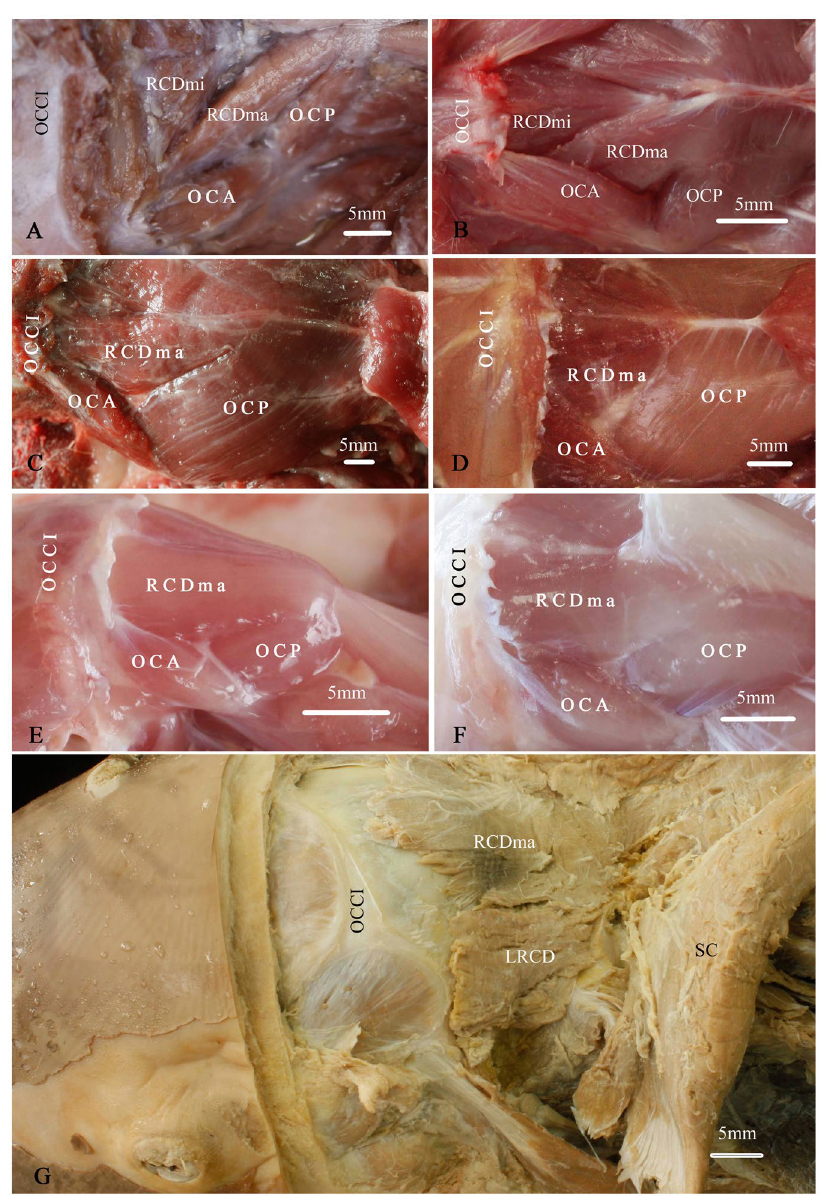
Figure 1. The post-occipital muscle group of five mammalian orders of mammals showed by the gross dissection (dorsal and lateral view). ( A ) Macacamulatta . ( B ) Oryctolaguscuniculus . ( C ) Canisfamiliaris . ( D ) Feliscatus . ( E ) Ratusnorvegicus . ( F ) Caviaporcellus . ( G ) Indoasian finless porpoise . The post-occipital muscles of Macacamulatta , Oryctolaguscuniculus , Canisfamiliaris , Feliscatus , Ratusnorvegicus , Caviaporcellus were composed of the rectus capitis dorsal major (RCDma), rectus capitis dorsal minor (RCDmi), oblique capitis anterior (OCA), and oblique capitis posterior (OCP). The RCDmi was covered almost entirely by the RCDma in Canisfamiliaris , Feliscatus , Ratusnorvegicus , and Caviaporcellus ( C , D , E , F ). While in Indoasian finless porpoise , the post-occipital muscles were composed of the rectus capitis dorsal minor (RCDmi), rectus capitis dorsal major (RCDma) and lateral rectus capitis dorsal (LRCD). The RCDma and LRCD were found in parallel arranged in the post-occipital region and the RCDmi was just ventral to the RCDma. SC: the semispinaliscapitis. OCCI: the occipital